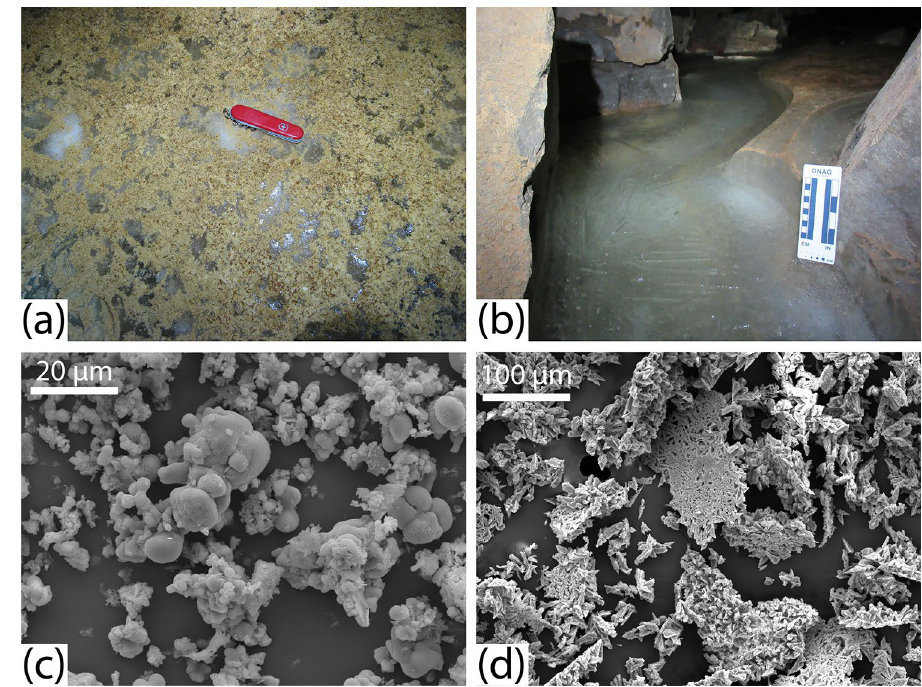
Figure 2. ( a ) Loose CCC coarse on the surface of the ice. Red knife is 10 cm long. ( b ) Pool of water with a lid of ice along the edge of the perennial ice. ( c ) SEM image of sample YS-6 (CCC coarse ) showing calcite spherules. ( d ) SEM image of sample TF (CCC coarse ) showing broken calcite